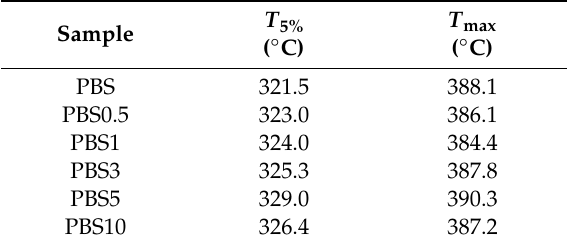
Figure 4. TGA curves of neat PBS and PBS / CB nanocomposites. Table 1. Summary of the TGA results for PBS / CB nanocomposites.